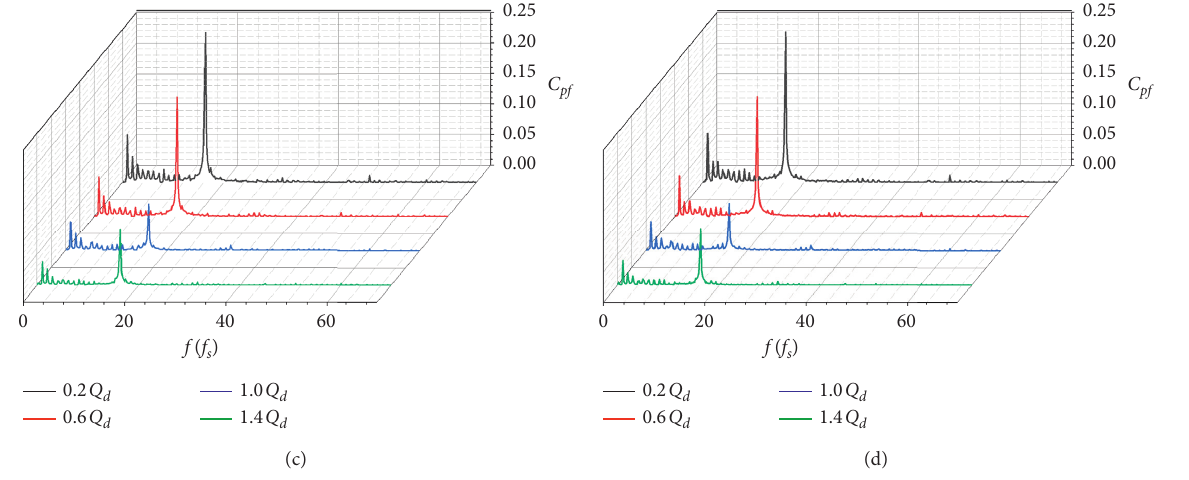
Figure 14: Pressure spectra of the diffuser for monitoring points: (a) 7, (b) 8, (c) 9, and (d)